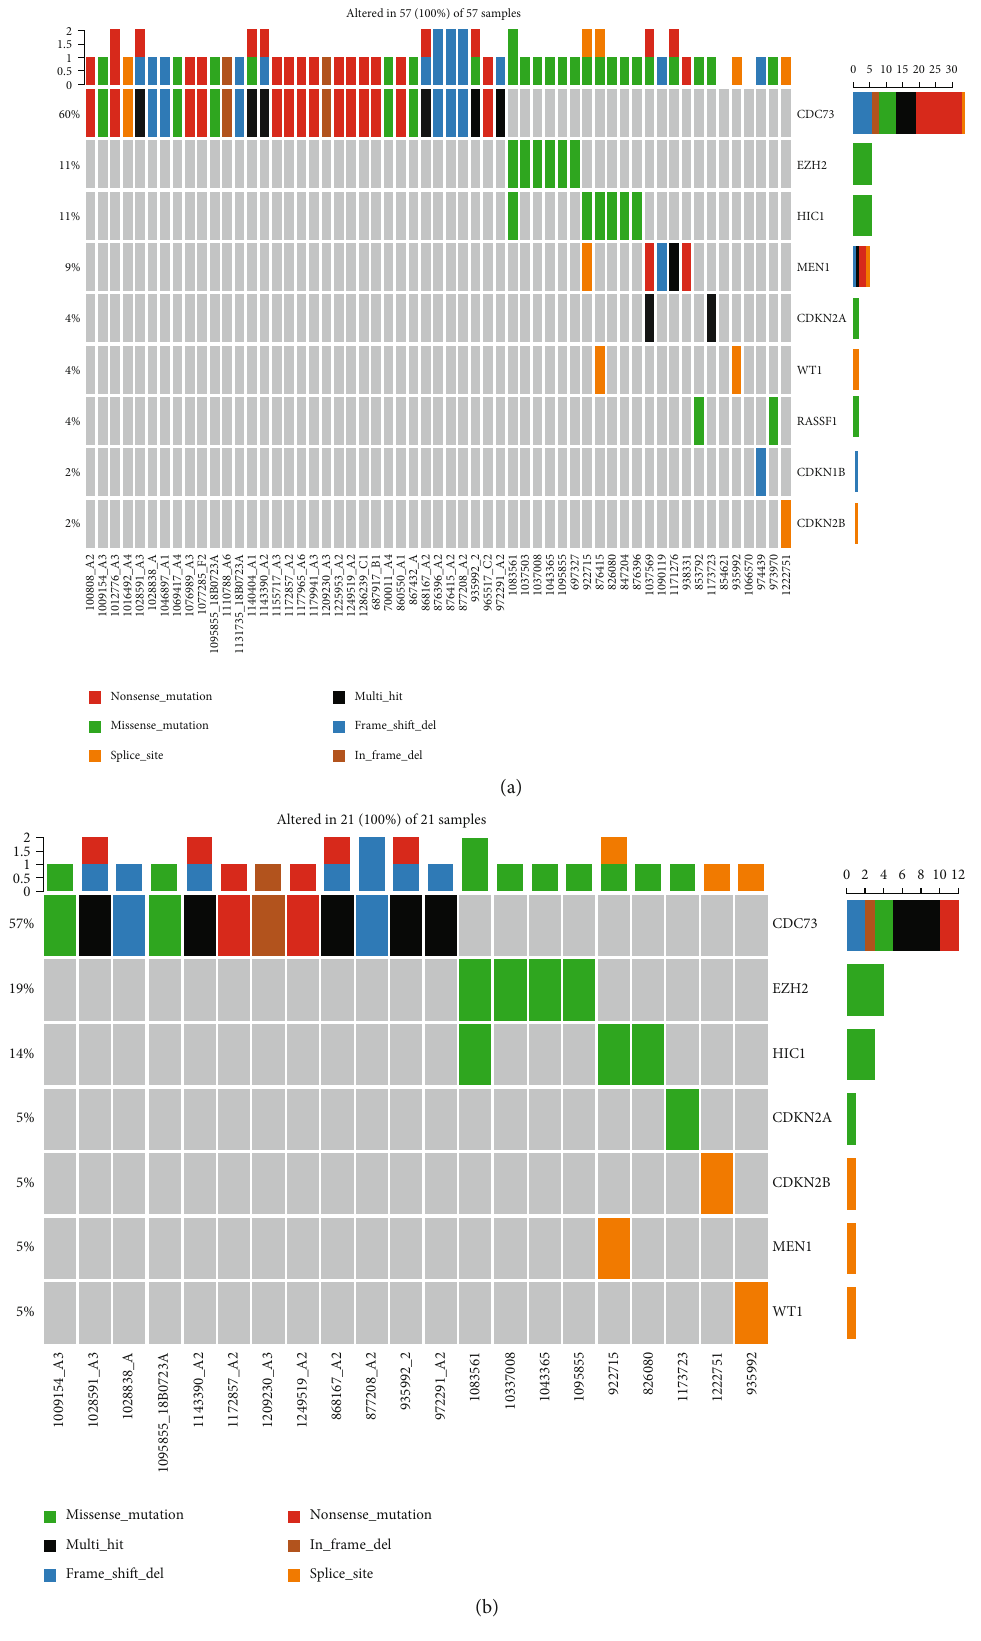
Figure 2: (a) and (b). Genetic landscapes of 50 atypical parathyroid adenomas and all 134 parathyroid tumor